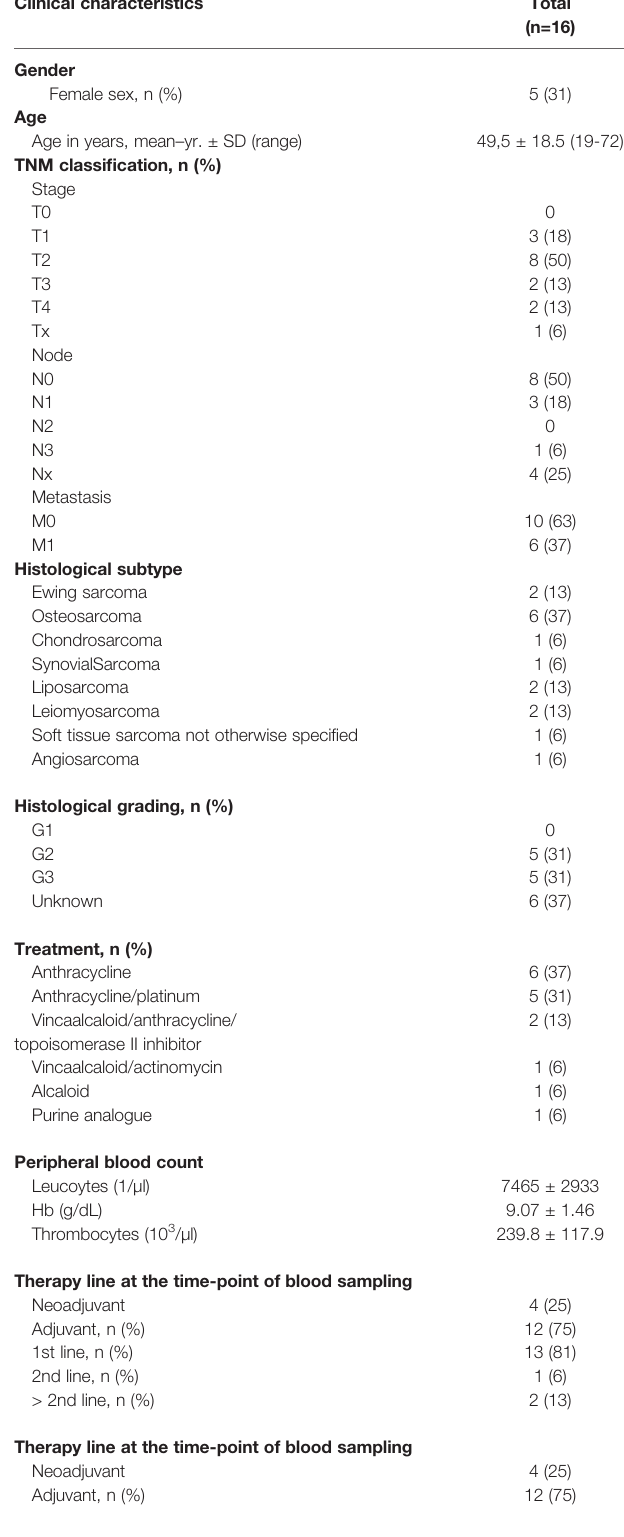
TABLE 1 | Patient